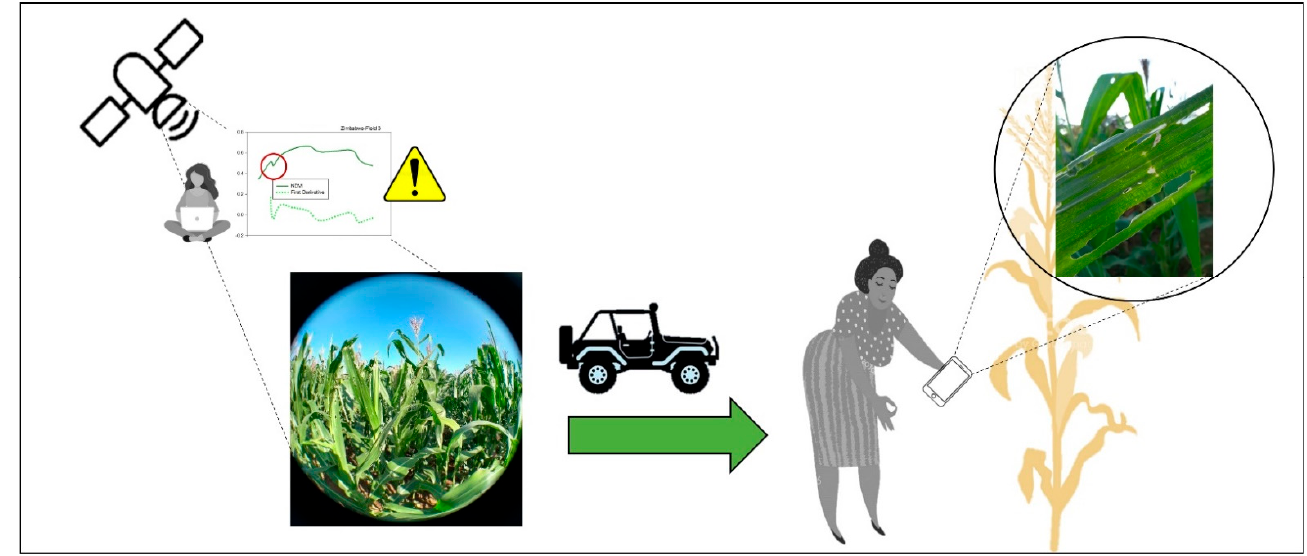
Figure 10. One tentative “solution” could be integrating at different scales of remote sensing.